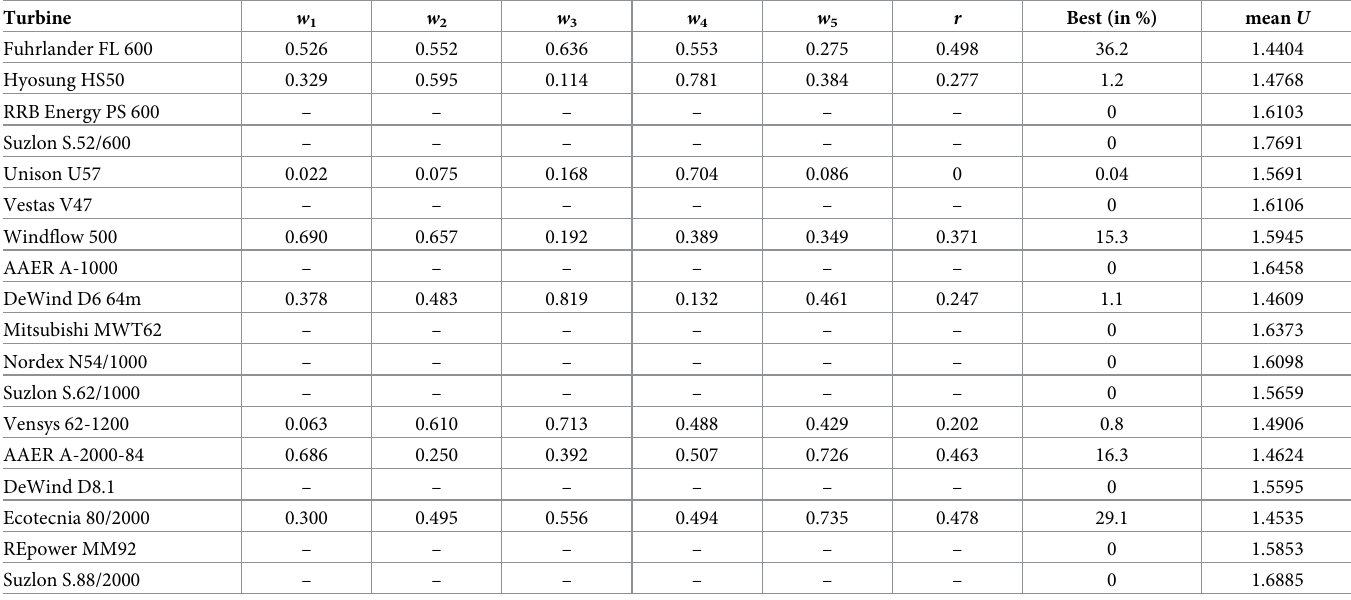
Table 8. Turbines, their central weights w � , radius r and a percentage of cases in which they were ranked